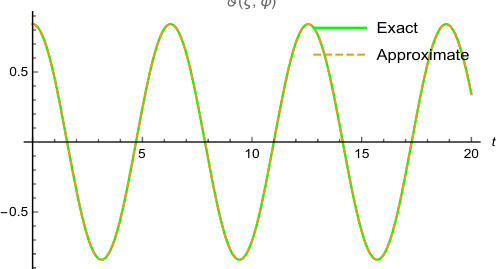
Figure 2. Graphical error between the approximate and precise results of ϑ ( ς , φ ) . Table 1. Absolute error between the approximate and exact solutions for Example 1.